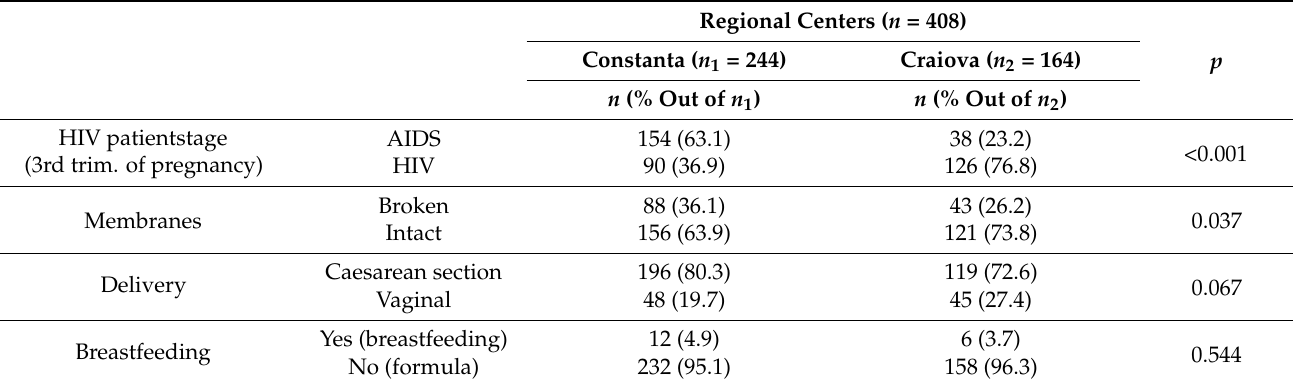
Table 3. Distribution ofHIV-positive pregnant women in both Constanta and Craiova RCs according to HIV patient scheme (3rd trimester of pregnancy), membranes, delivery, and breastfeeding variables. Regional Centers ( n = 408)